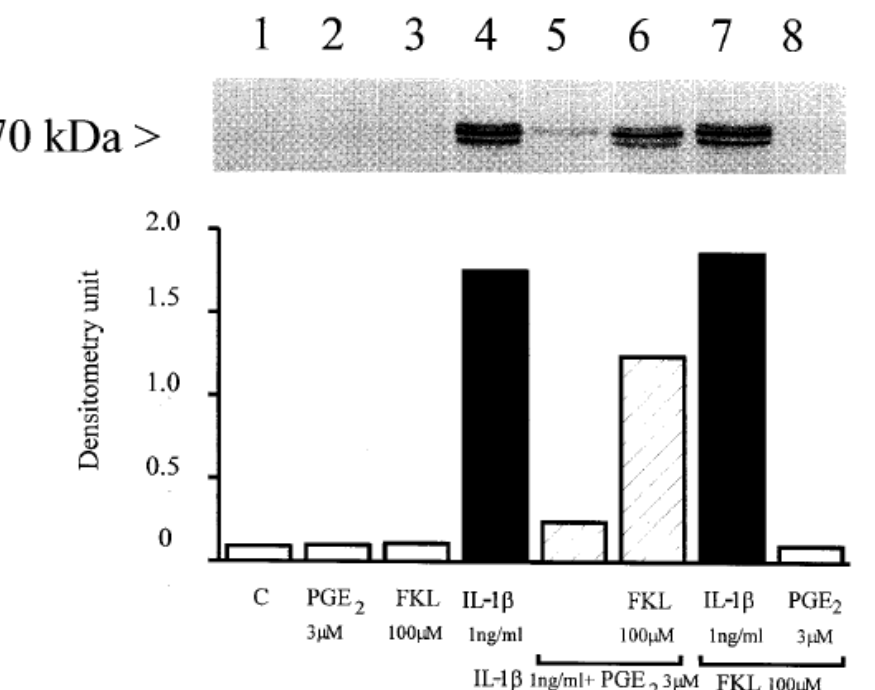
FIG. 6. The effects of forskolin on COX-2 protein expressed in IL-1 b (1ng/ml) plus PGE 2 (3 m M) treated HUVEC. COX-2 protein was detected by Western blots using polyclonal antibodies to COX-2 in cell extracts of HUVEC treated with no addition (lane 1), PGE 2 (3 m M; lane 2) alone, forskolin (100 m M; lane 3) alone, IL-1 b (1ng/ml; lane 4) alone, IL-1 b (1ng/ml) plus PGE 2 (3 m M; lane 5), IL-1 b (1ng/ml) plus PGE 2 (3 m M) with forskolin (100 m M; lane 6), IL-1 b (1ng/ml) plus forskolin (100 m M; lane 7) or PGE 2 (3 m M) plus forskolin (100 m M; lane 8) for 24h. Equal amounts of protein (20 m g/lane) were loaded in each lane. Similar results were obtained with cell extracts from three separate batches of cells. The significant differences between each band were compared by scanner densitometry using image 1D program (densitometry